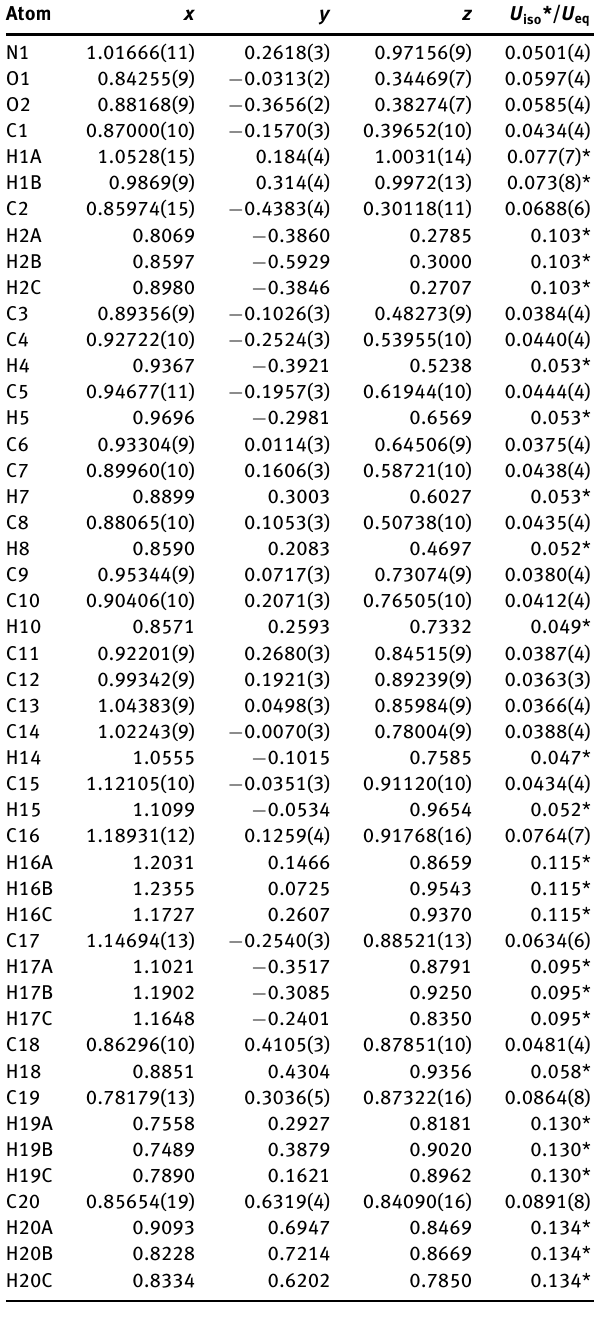
Table 2: Fractional atomic coordinates and isotropic or equivalent isotropic displacement parameters (Å 2